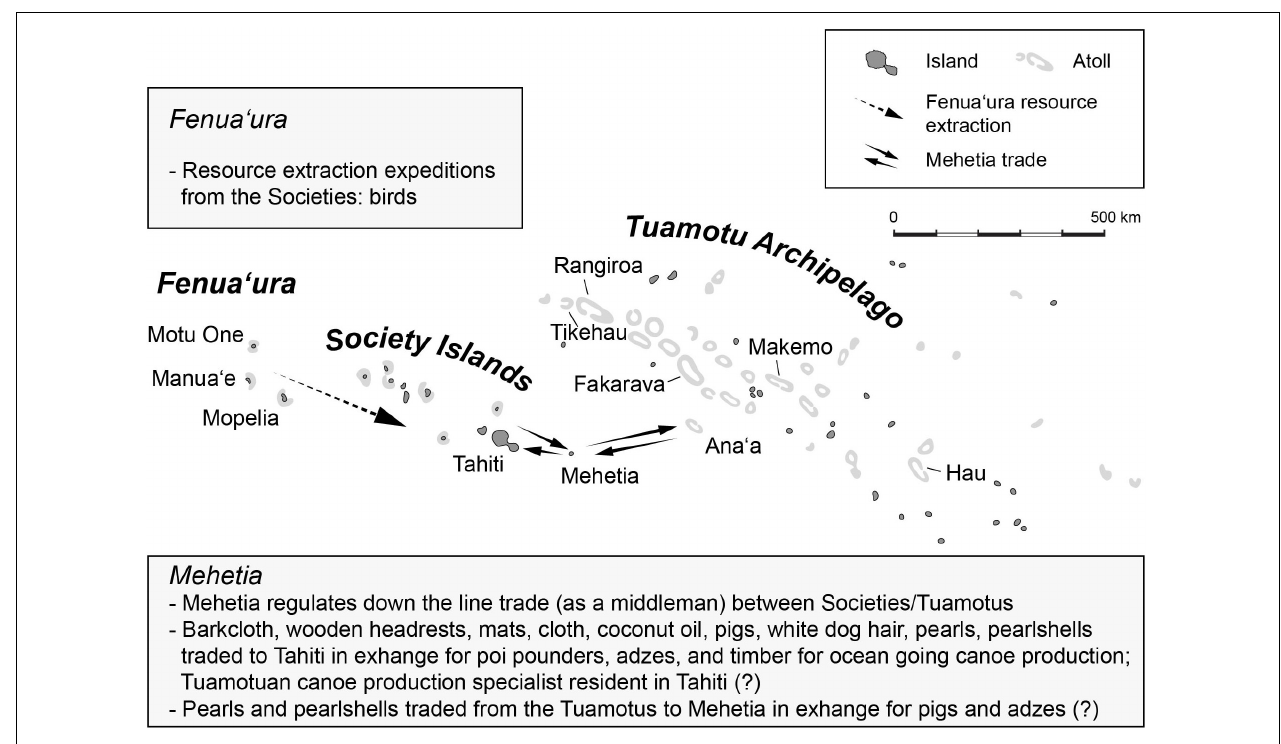
FIGURE 2 | Visual map of the Society Islands as the principal agent in Fenua-Ura resource extraction and as a key node in the Society Island-Mehetia-Tuamotu. Phrases followed by (?) denote possible interpretations that we have less solid foundation for regional interaction sphere.